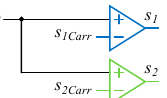
Figure 4. PWM scheme in the proposed operation mode.